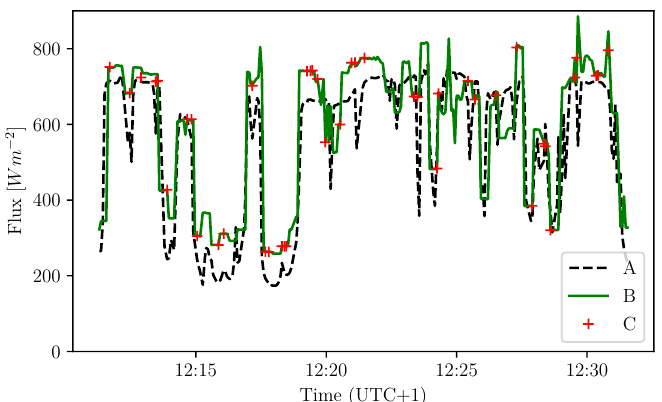
Figure 7. Comparison of the different solar flux computations for the test conducted on 26 October 2020. ( A ) pyranometer flux corrected of the Sun’s elevation; ( B ) photodiodes’s flux corrected of the reference attitude; ( C ) photodiodes’s normalized flux corrected of the predicted